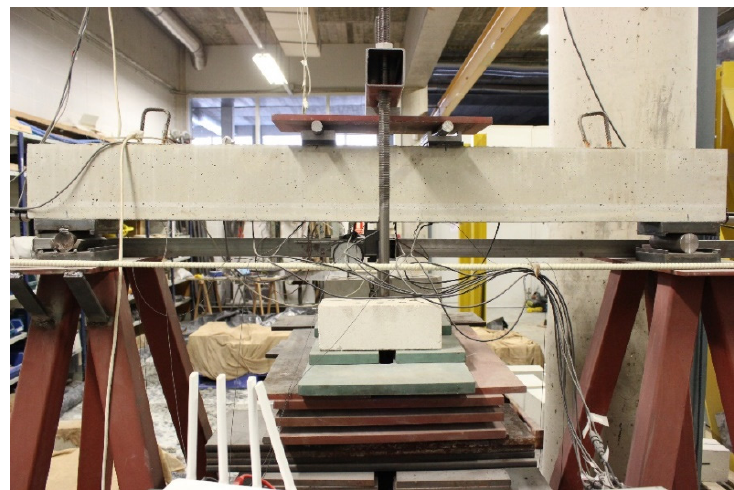
Figure 2. Configuration of the experimental test.